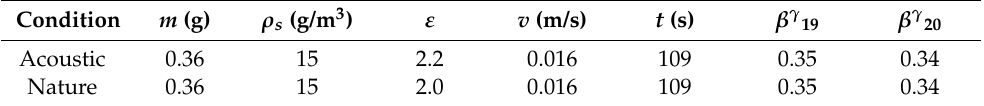
Table 2. Calculation